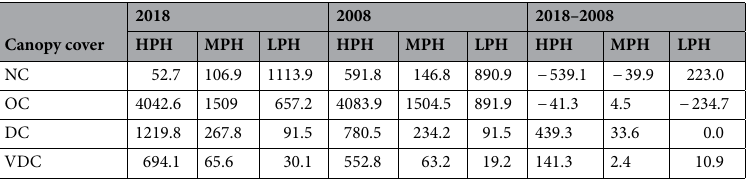
Table 2. Canopy cover in different potential habitat in 2008 and 2018 (area in sq. km). No canopy (NC), Open canopy (OC), Dense canopy (DC), Very dense canopy (VDC), High potential habitat (HPH); Moderate potential habitat (MPH) and Low potential habitat